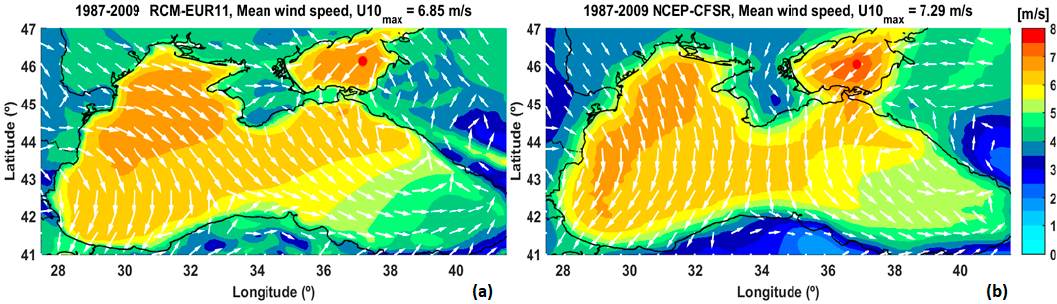
Figure 2. The averaged wind speed is represented in the background, while the wind vectors indicate the average wind direction over the Black Sea: ( a ) EUR11, ( b ) NCEP.